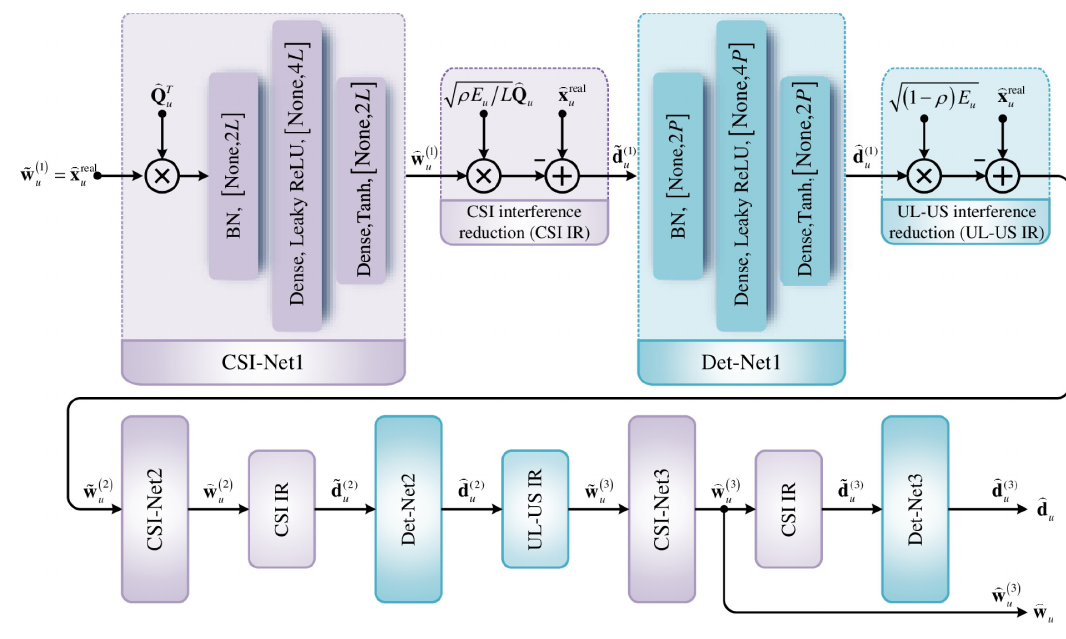
Fig 2. Detection network.